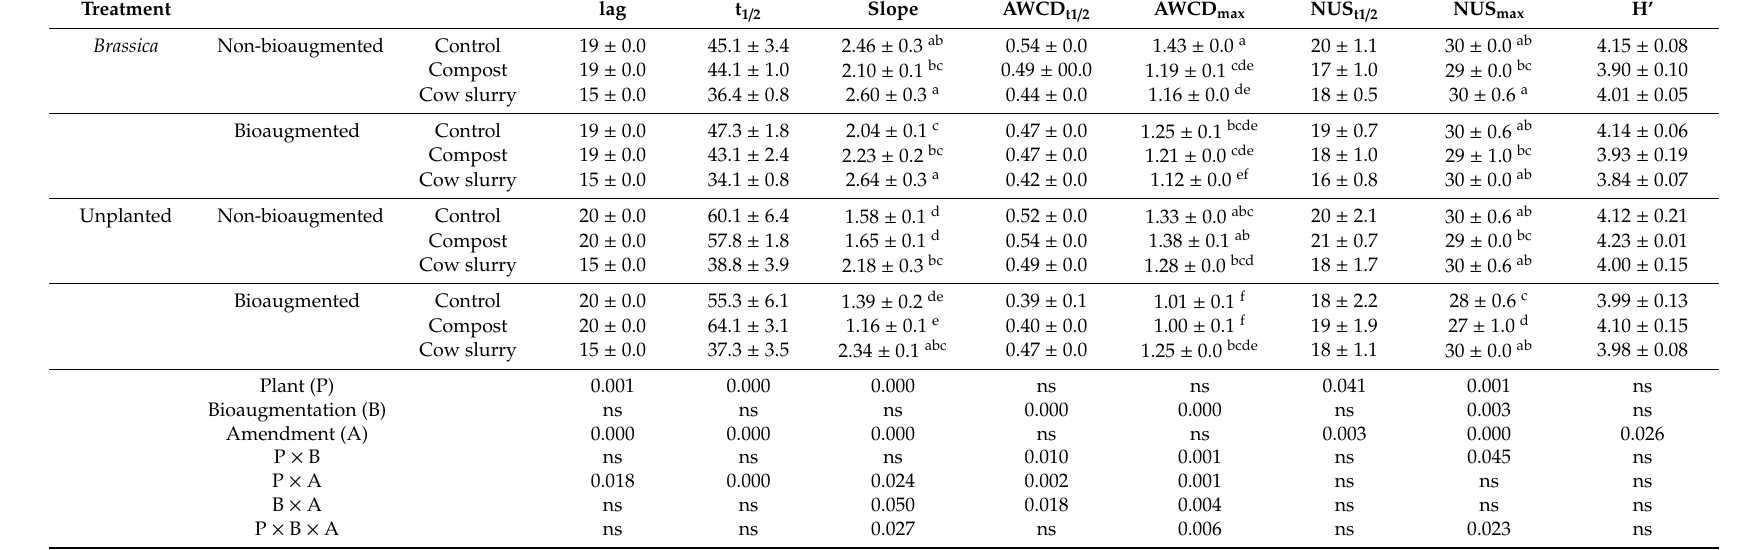
: time corresponding to the middle of the 2